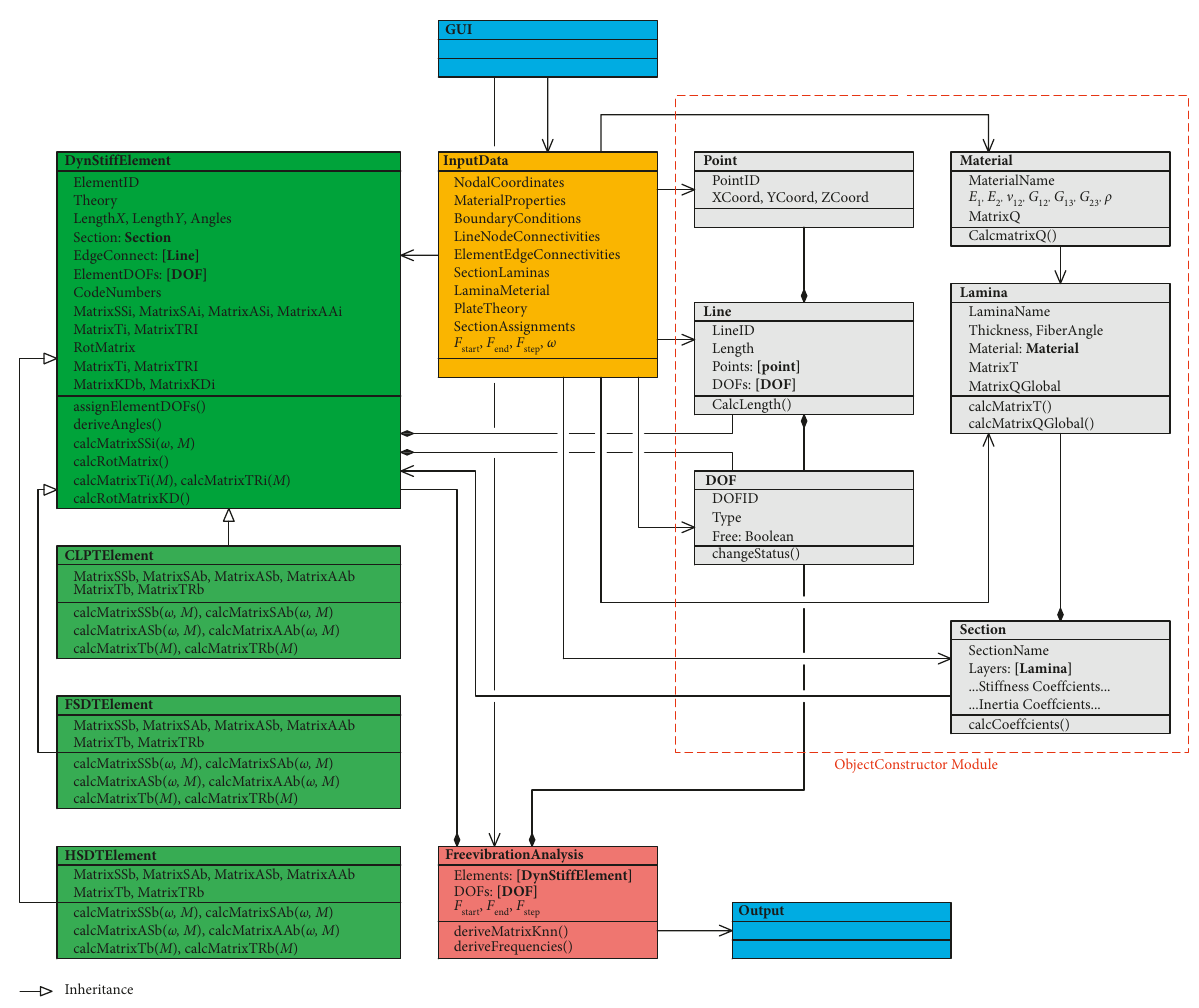
Figure 4: Relationships of classes in